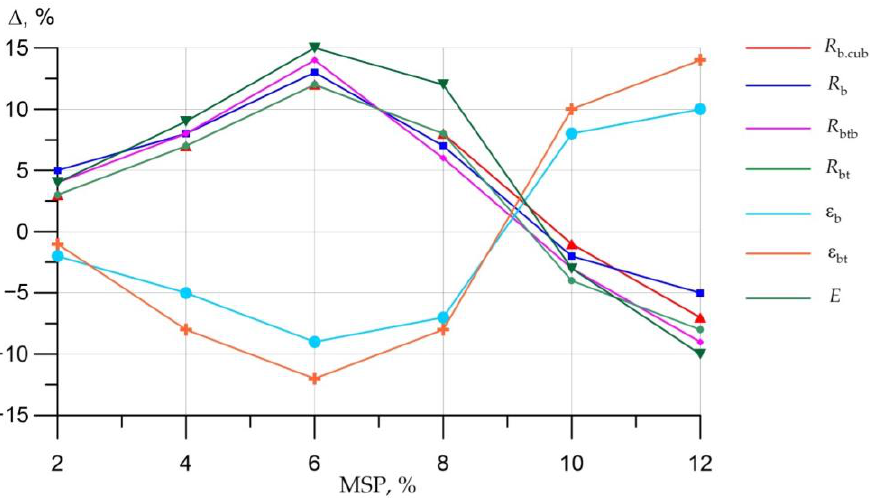
Figure 15. Curves of change in strength and deformation characteristics (SSC) in percentage terms compared to the control composition.